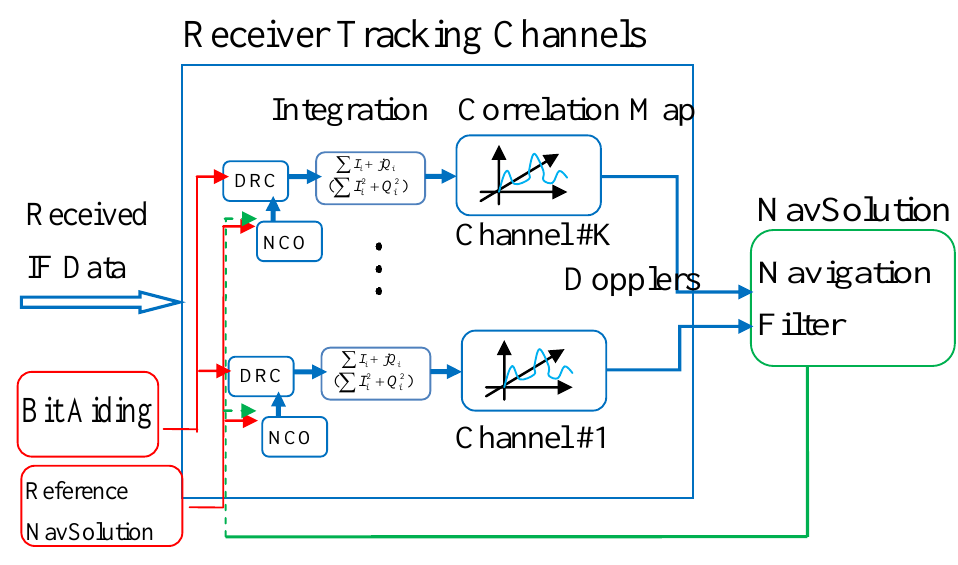
Figure 1. Conventional high sensitivity GNSS receiver architecture.